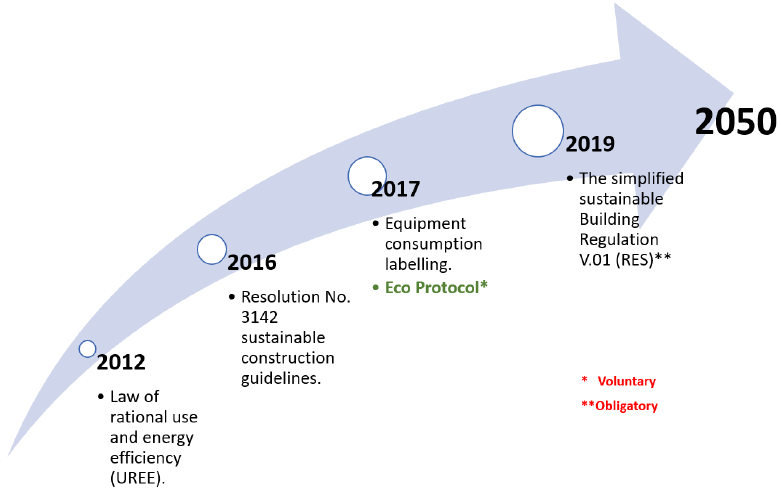
Figure 11. Chronologic timeline for recent regulations establishment in Panama. However, at this point, all regulations have been only voluntary. In contrast, in